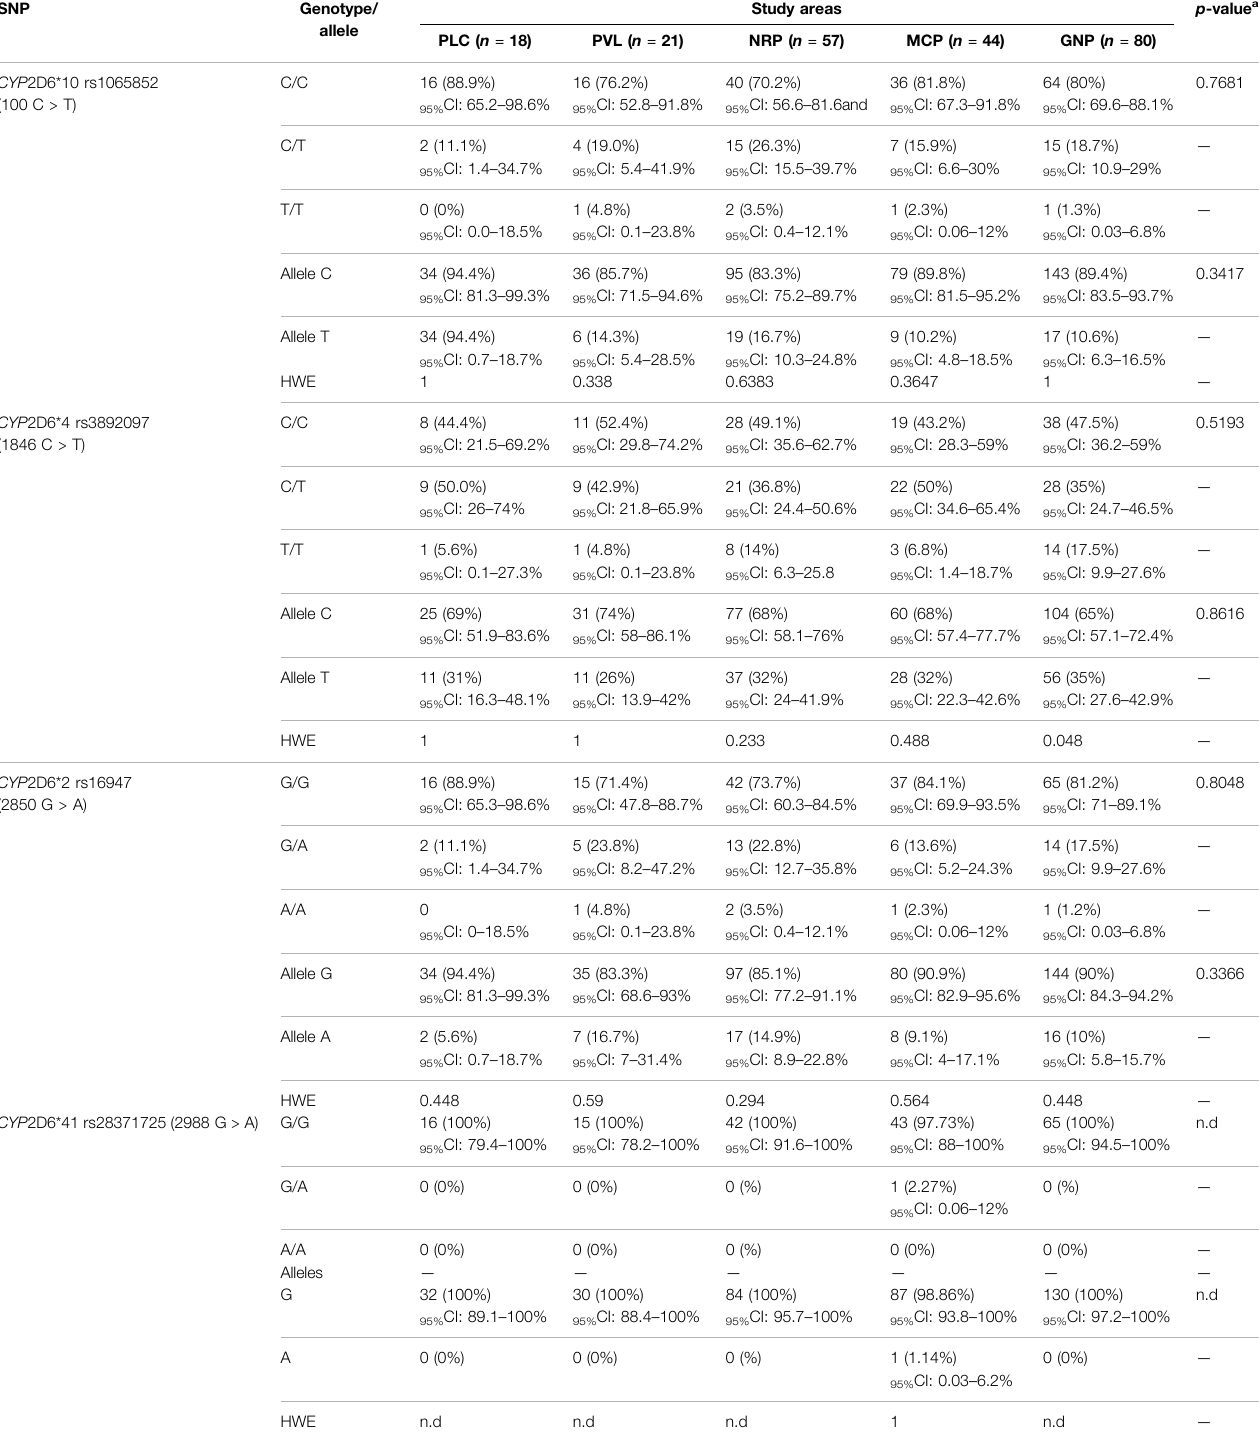
Frequencies were determined by direct counting considering the total number of subjects genotyped from each region. Con fi dence intervals were estimated using the Clopper-Pearson exact method. a p values were determined for comparisons between genotype distributions of the different areas using a Chi-square test. PLC (cid:1) Plácido de Castro; PVL (cid:1) Porto Velho; NRP Novo Repartimento; MCP (cid:1) Macapá; GNP (cid:1) Goianésia do